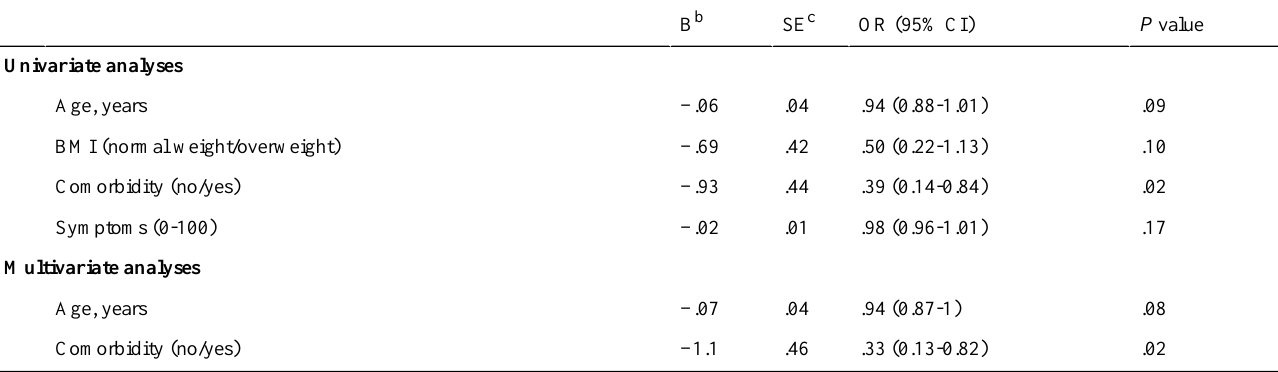
Table 2. Univariate and multivariate analyses for predictors for usage a